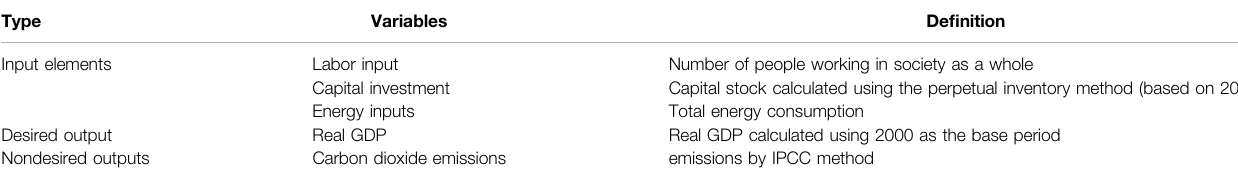
TABLE 2 | Measures of green total factor productivity.